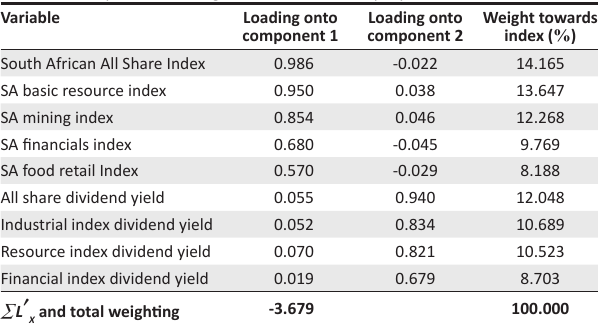
TABLE 4: Component loadings of South African equity market